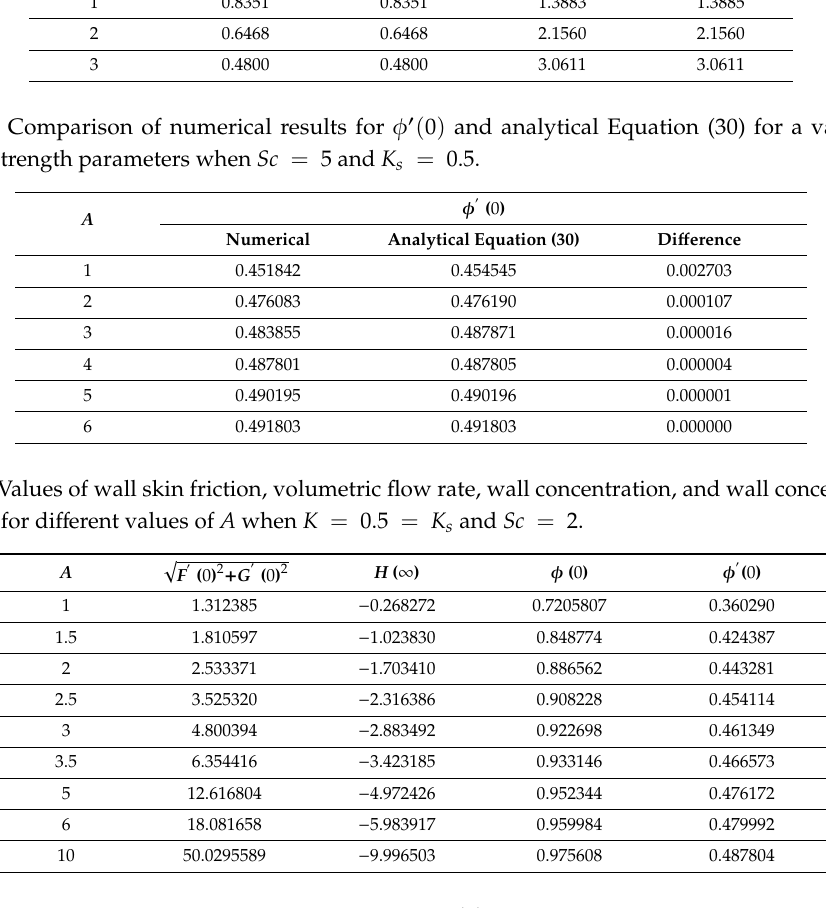
Table 4. Computation results of wall concentration φ ( 0 ) and wall concentration gradient φ (cid:48) ( 0 ) for various values of K , K s , and Sc when A =